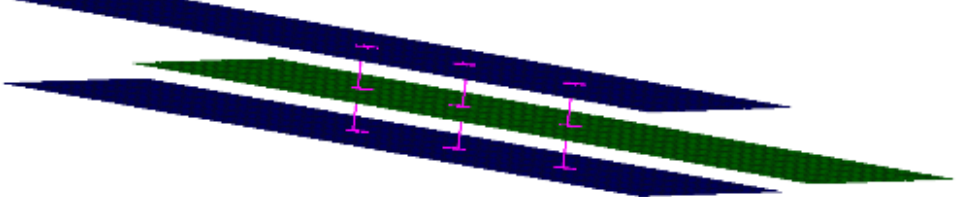
Figure 4. Two-dimensional finite element model of the bolted joint.